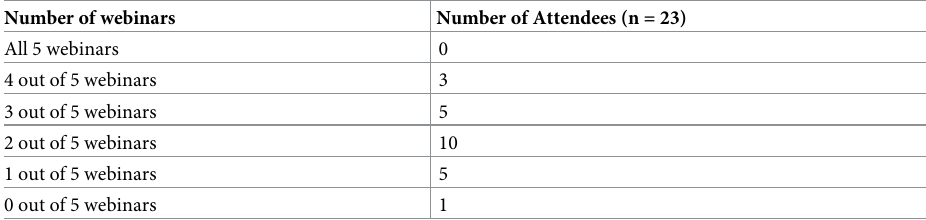
Table 9. Webinar attendance